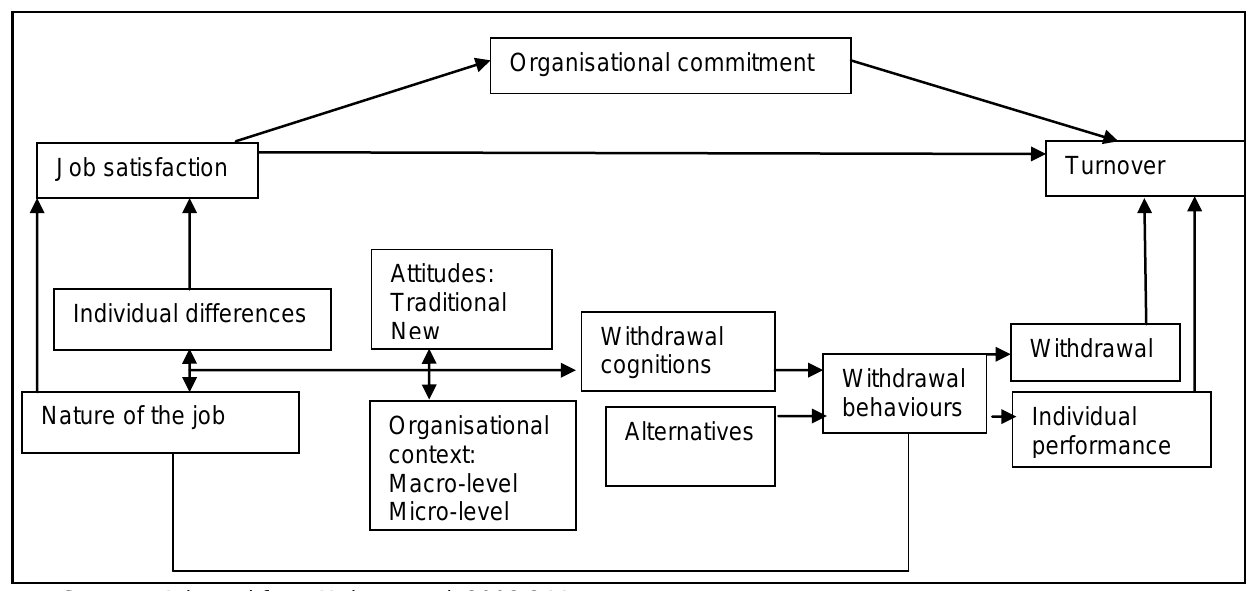
Figure 1: Turnover model proposed by Holtom et al.